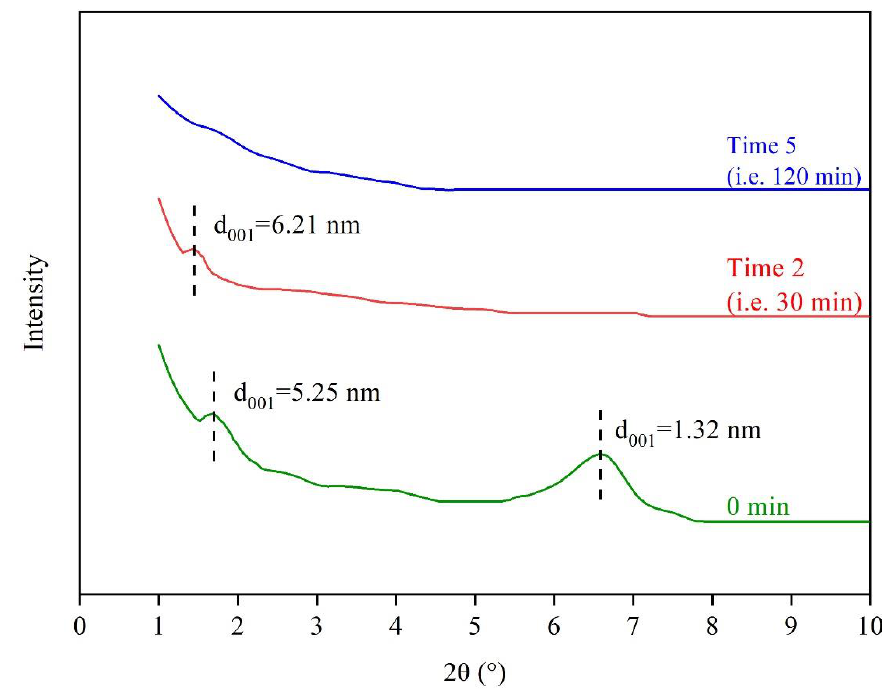
Figure 11. XRD spectrum of Mt-CRMB binder at different times.